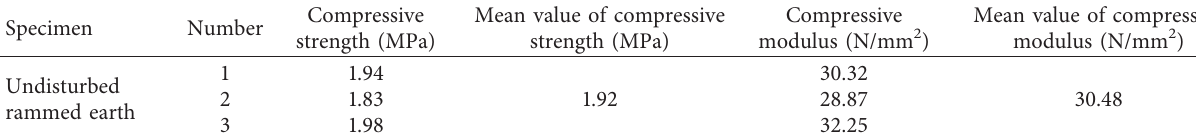
Table 4: Compression modulus and compressive strength of undisturbed rammed earth.